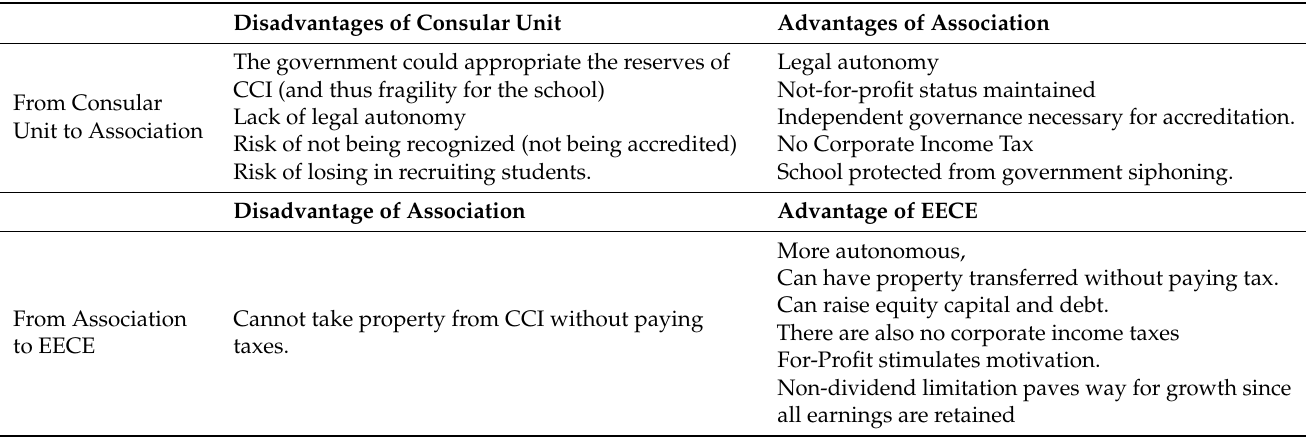
Table 4. Instituional motivations for legal transformation from Consular Unit to Social